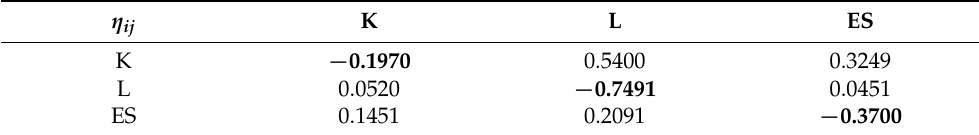
Table 5. Price elasticity of input factors in